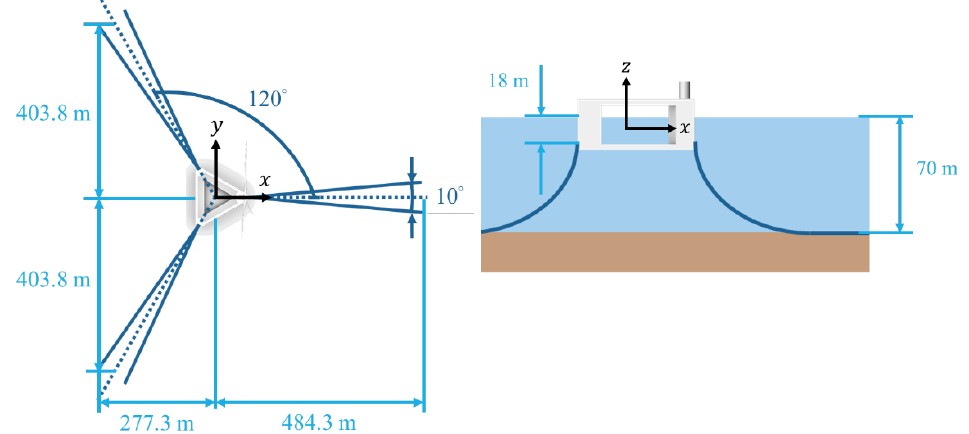
Figure 2. Mooring design of wind turbine system. Table 3. Specifications of IEA 15 MW offshore wind turbine.